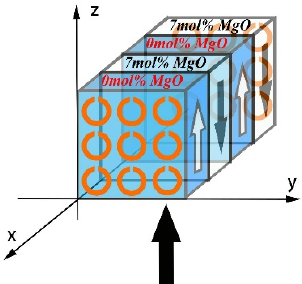
Figure 1. A schematic diagram of the MPPC, which is composed of a one-dimensional IPPLNC and SRRs. The positive and negative domains of the MPPC are arranged periodically along the x- axis. The arrows along the positive and negative z -axes indicate the positive and negative domains, respectively. The Mg concentrations in the positive and negative domains are 0 mol% and 7 mol%, respectively. The bottom arrow indicates the direction of y-polarized EM wave propagation. Here, only two periods of the MPPC have been shown.